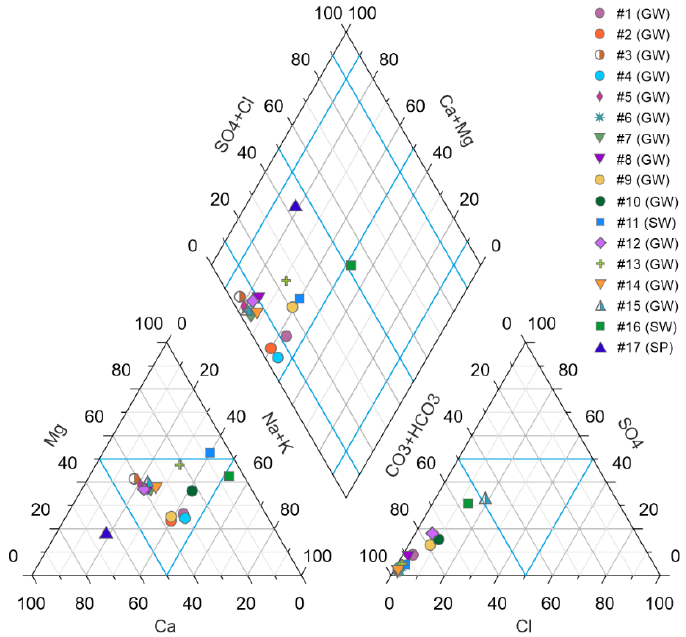
Figure 5. Piper diagram shows the common water